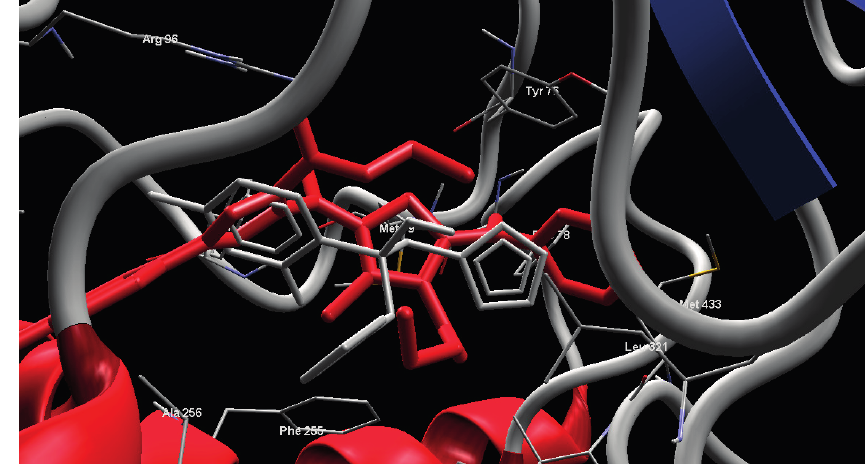
Figure 6. Superimpose of the co-crystallized fluconazole ( Gray ) and compound 9b ( Red ) in the active site of cytochrome P450 14 α -sterol